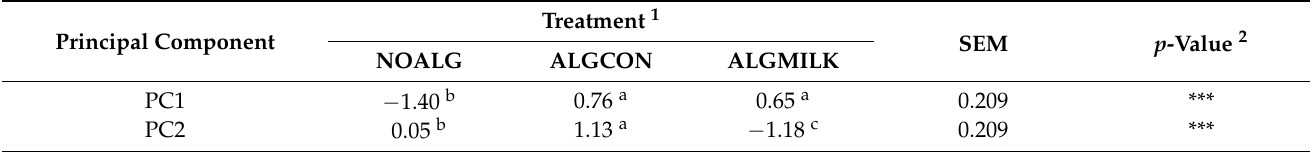
Figure 1. Principal component analysis of volatile compounds and thiobarbituric acid reacting substances (TBARS) in meat from lambs fed a control diet (NOALG) and lambs with competent reticular groove reflex fed the control diet supplemented with 2.5% marine algae meal mixed in the concentrate (ALGCON) or in a milk replacer (ALGMILK). Only selected volatile compounds with loadings greater than ±0.6 are shown. Numbers refer to the ordinal number assigned to each volatile compound in Table 2. Blue circles represent the position of the samples in the principal component space and yellow circles are the centroids of each group. Table 3. Results of ANOVA of the principal component scores obtained from the principal compo- nents analysis shown in Figure